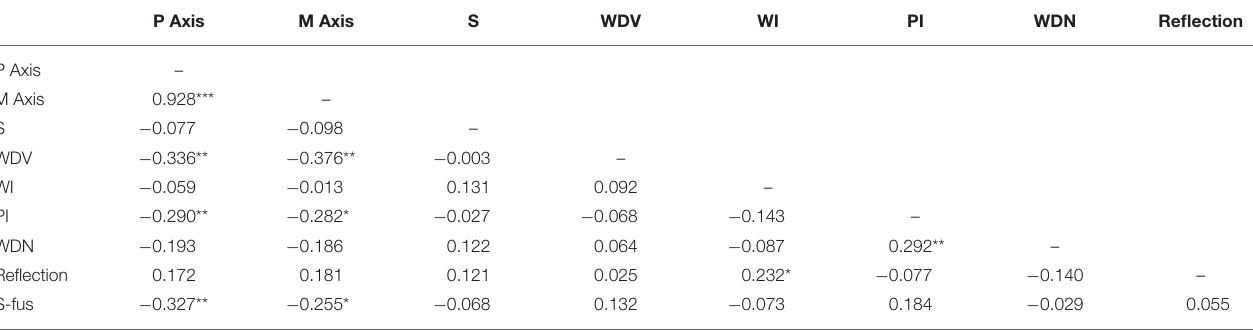
TABLE 4 | Partial correlations (controlling for coded responses on the Lerner Defense Scale) among Psychodiagnostic Chart-2 (PDC-2), LDS, and Rorschach variables. P Axis M Axis S WDV WI PI